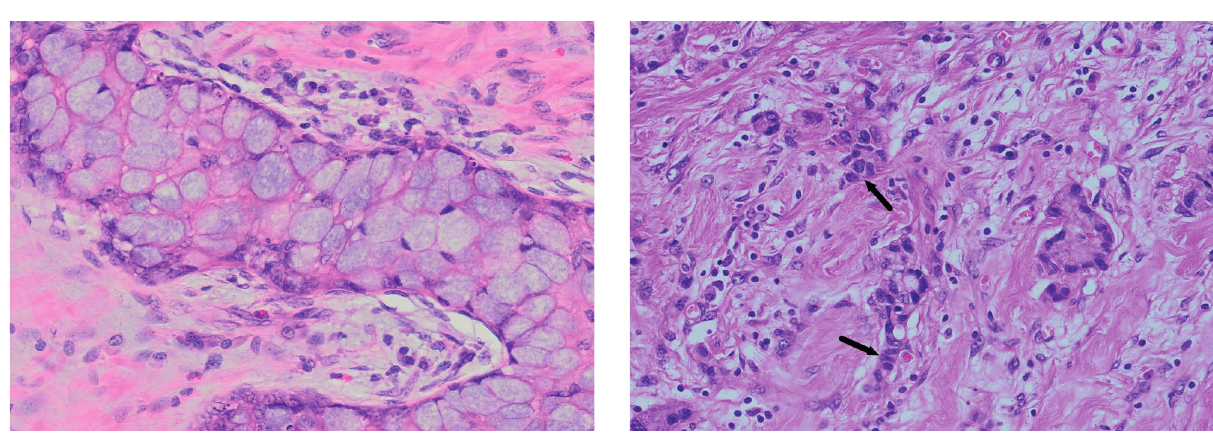
Fig. 1. Characteristic histological pattern of tumor cells with an appearance consistent with goblet cells or signet ring cells (HE, 200x).